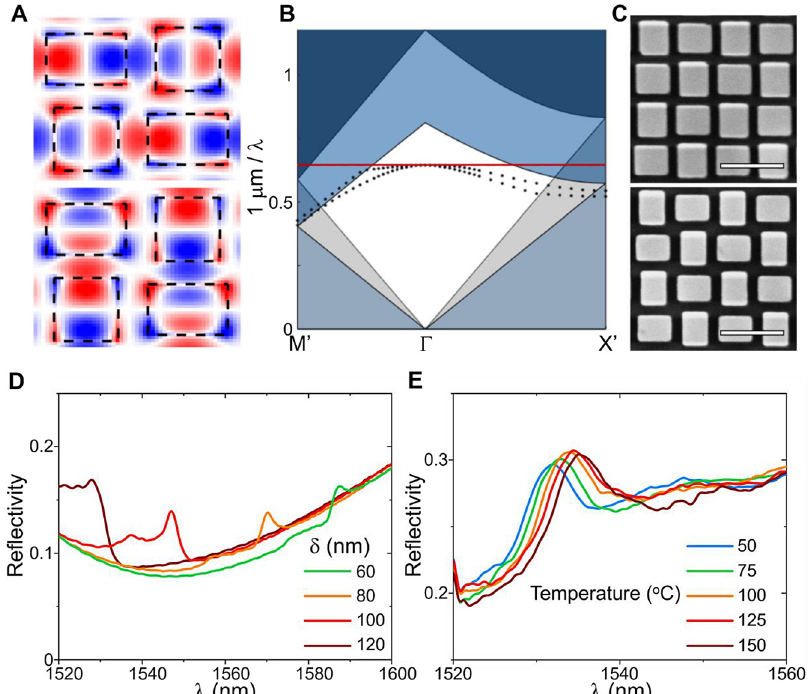
Figure 3: Design and experimental results of two-dimensional (2D) polarization- insensitive metasurface